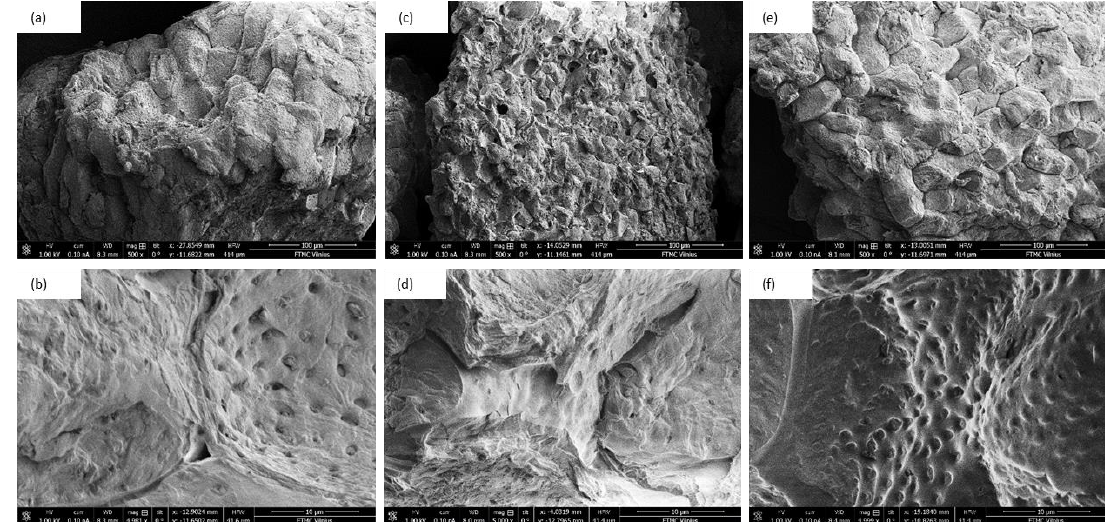
Figure 3. SEM results of ( a , b ) non-treated WS ( c , d ) acetylated WS, and ( e , f ) silanized WS.